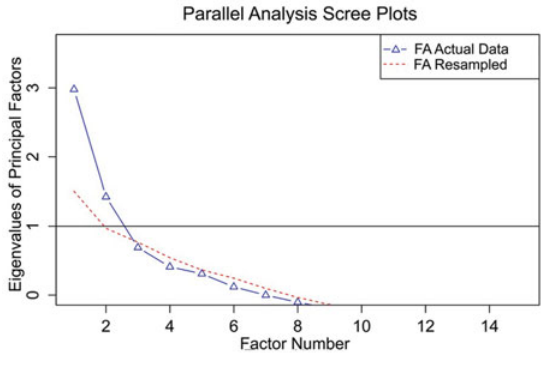
FIGURE 2 (Colour online) Parallel analysis plots for two factor